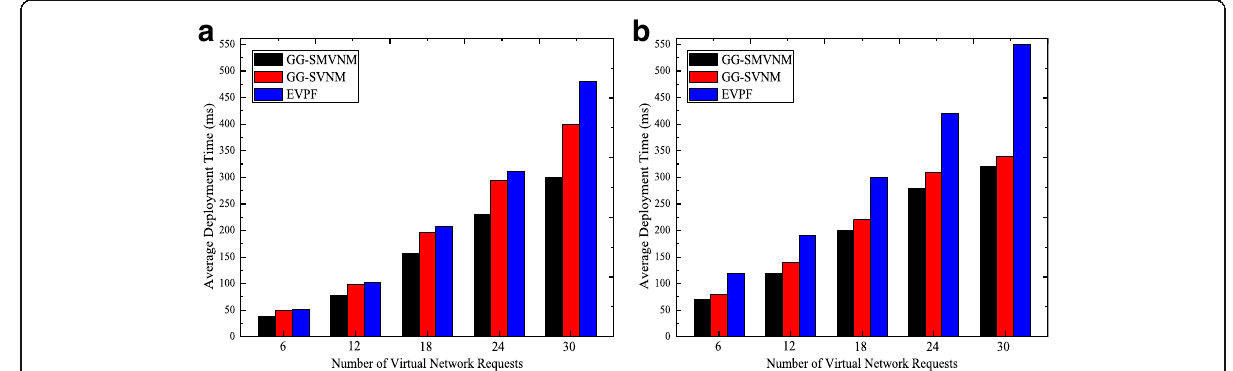
Fig. 10 Simulation results for deployment time. a Simulation results on Net-1. b Simulation results on